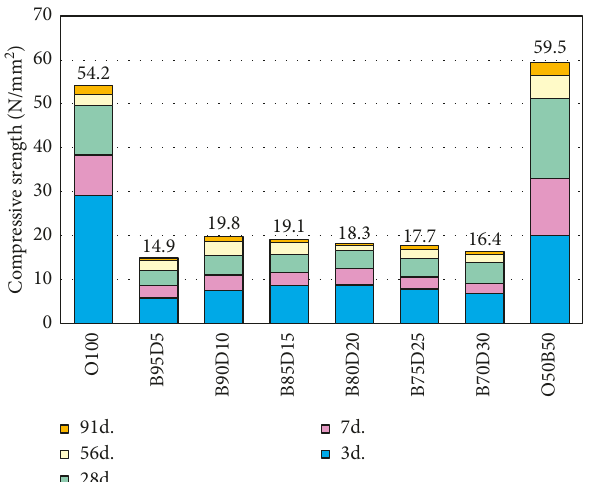
Figure 4: Compressive strength ratios by binder types.